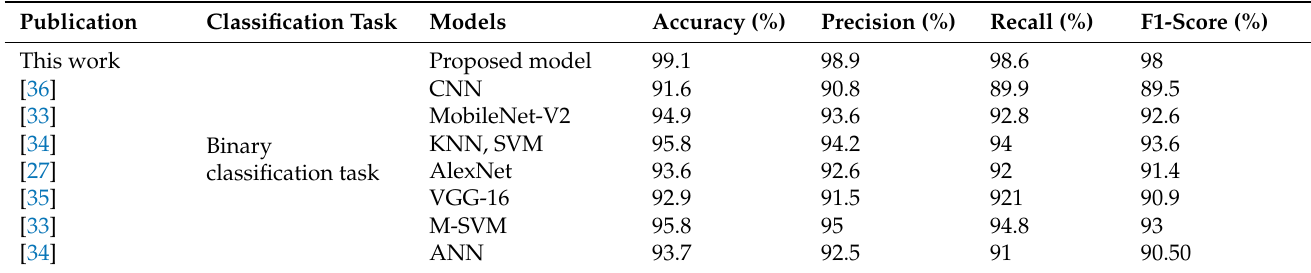
Figure 14. Comparative results of DL model with proposed model for BTs classification. Table 4. Presents the comparative analysis of proposed model with recent ML/DL model.